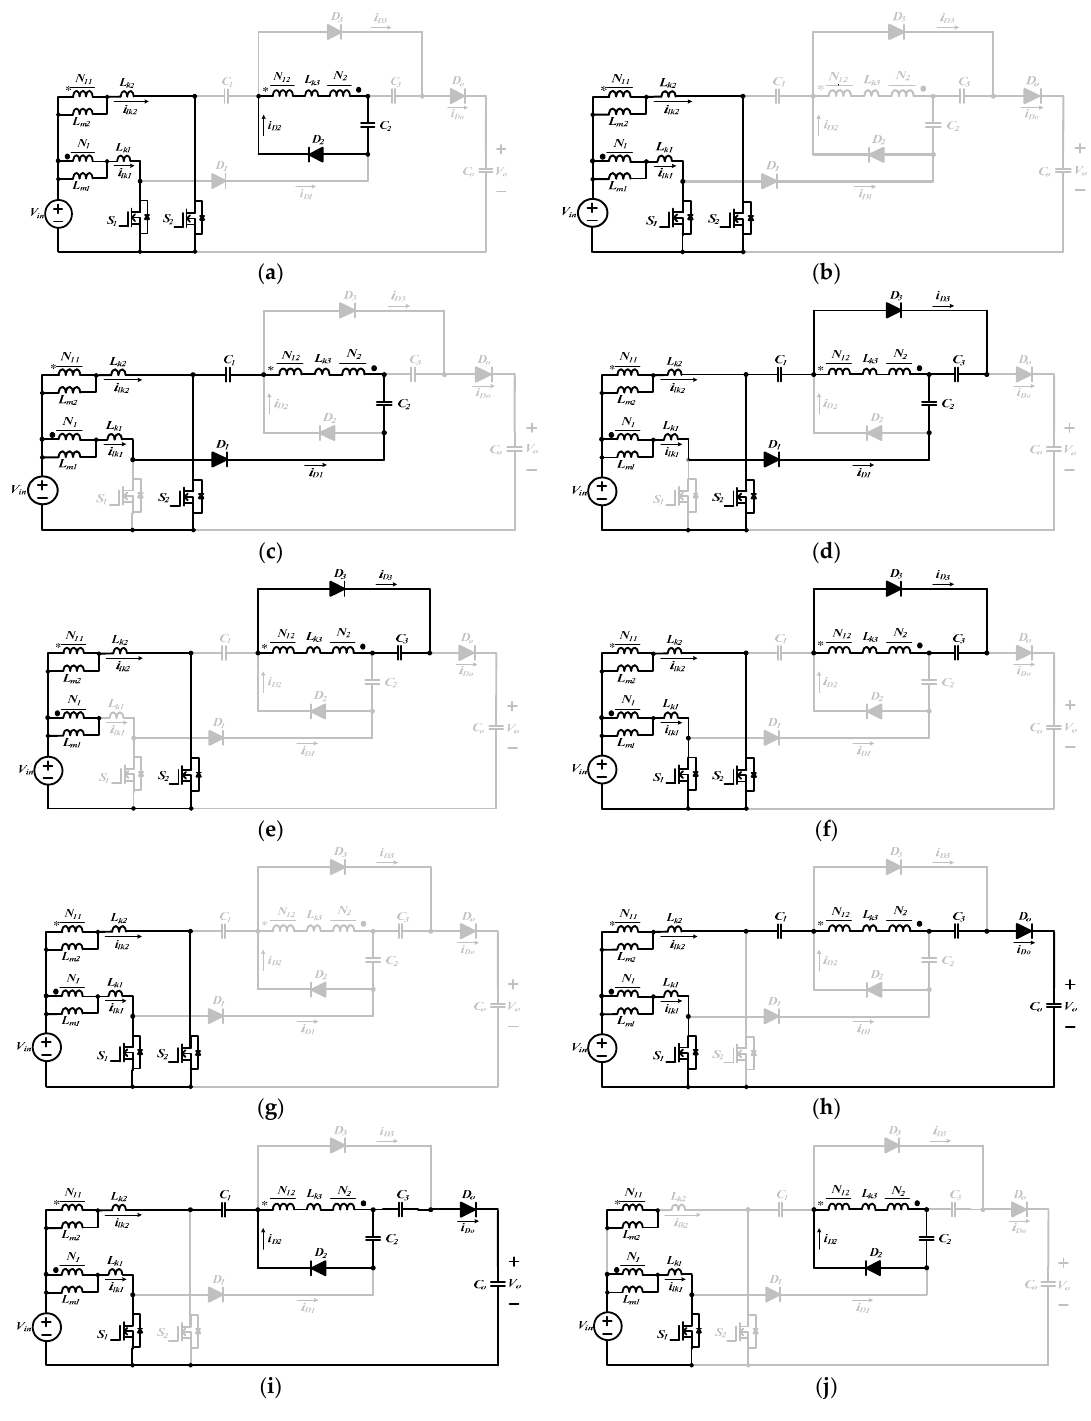
Figure 2. Mode equivalents of the proposed NIC over one switching period. ( a ) Mode 1 ( t 0 – t 1 ); ( b ) Mode 2 ( t 1 – t 2 ); ( c ) Mode 3 ( t 2 – t 3 ); ( d ) Mode 4 ( t 3 – t 4 ); ( e ) Mode 5 ( t 4 – t 5 ); ( f ) Mode 6 ( t 5 – t 6 ); ( g ) Mode 7 ( t 6 – t 7 ); ( h ) Mode 8 ( t 7 – t 8 ); ( i ) Mode 9 ( t 8 – t 9 ); and ( j ) Mode 10 ( t 9 – t 10 ).